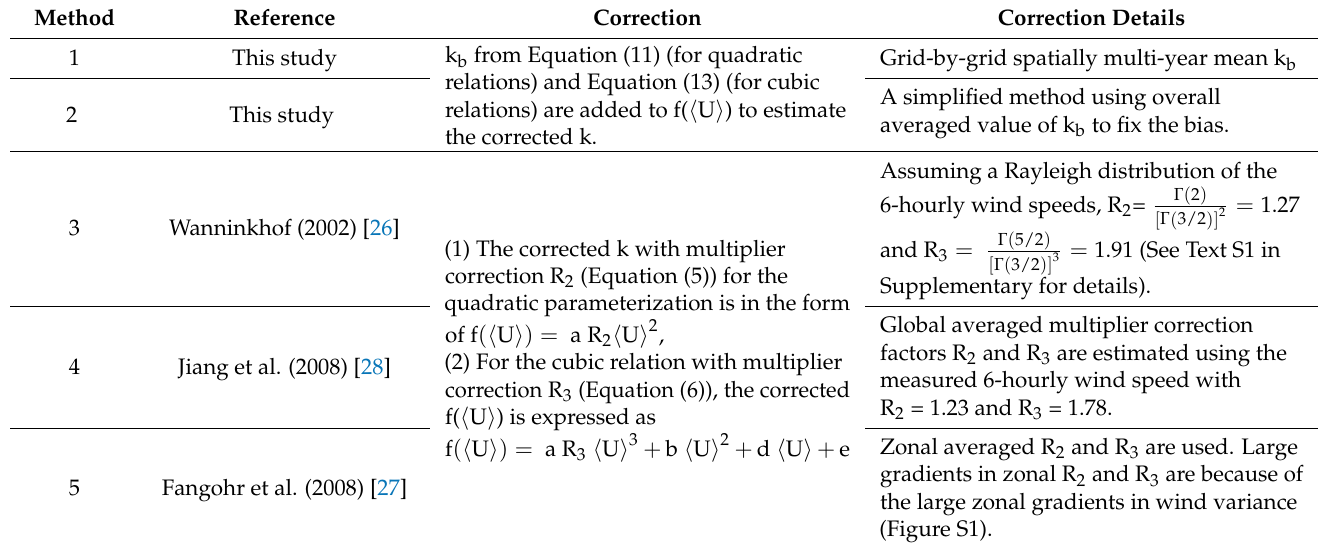
Table 2. Summary of all the correction methodologies for CO 2 and other gases.